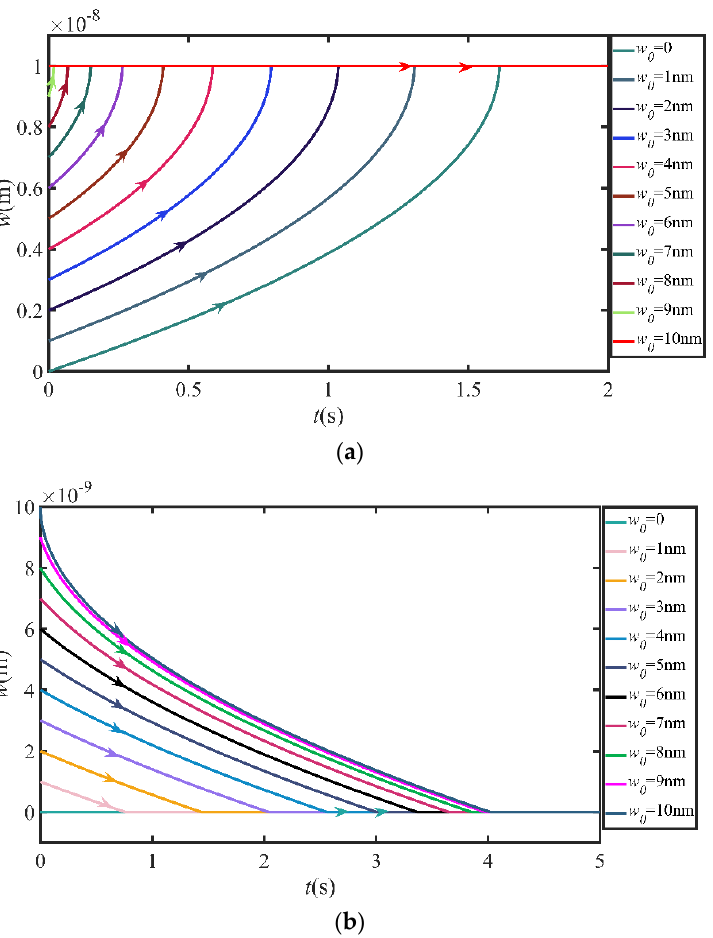
Figure 2. Transient response of the memristor under DC. ( a ) Corresponding voltage v m = 0.5 V; ( b ) corresponding voltage v m = − 0.2 V. The initial value is w 0 ∈ {0, 1 nm, 2 nm, 3 nm, 4 nm, 5 nm, 6 nm, 7 nm, 8 nm, 9 nm, 10 nm}.